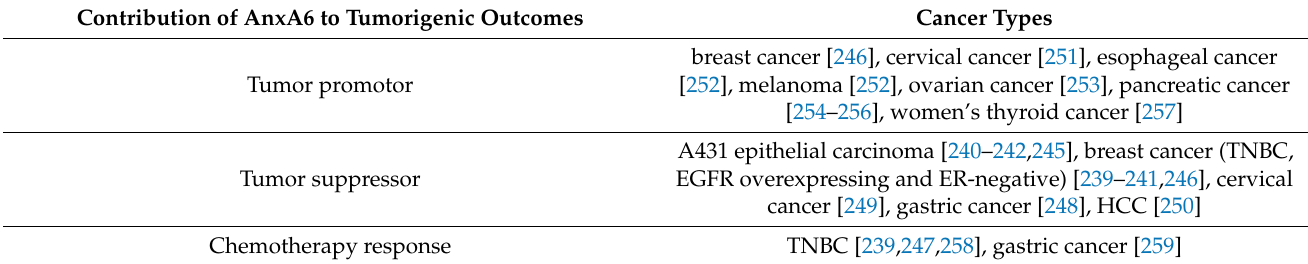
Table 5. Roles of AnxA6 in